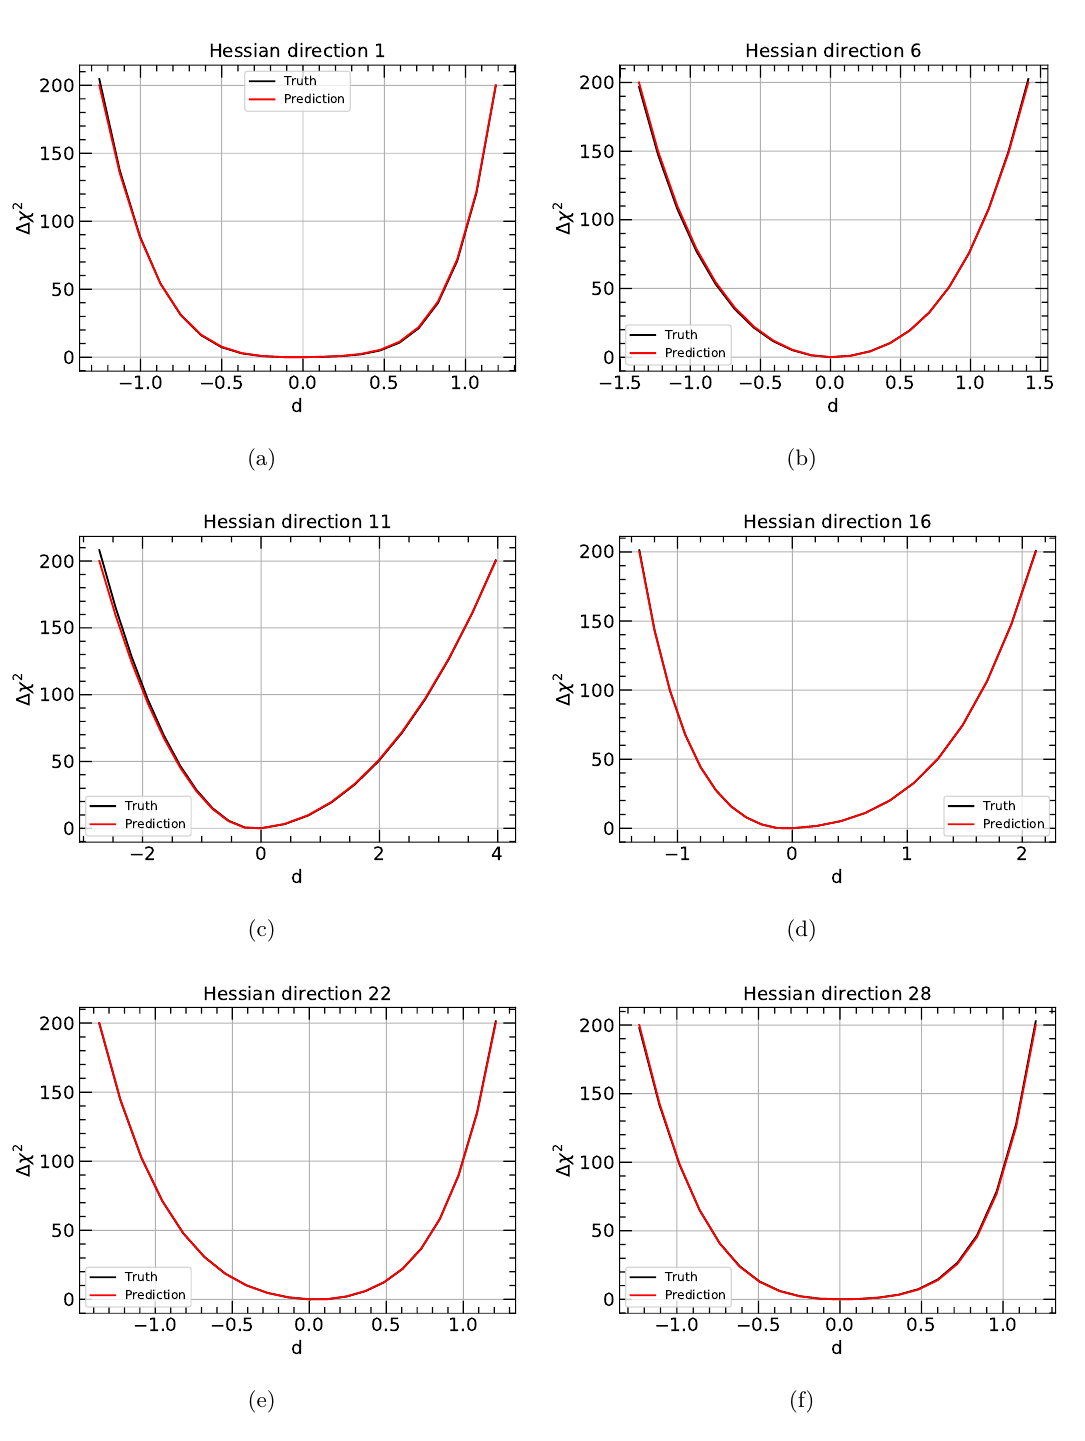
Figure 4 . The variation of ∆ χ 2 with d along the 1st, 6th, 11th, 16th, 22th and 28th CT18NNLO Hessian eigenvector